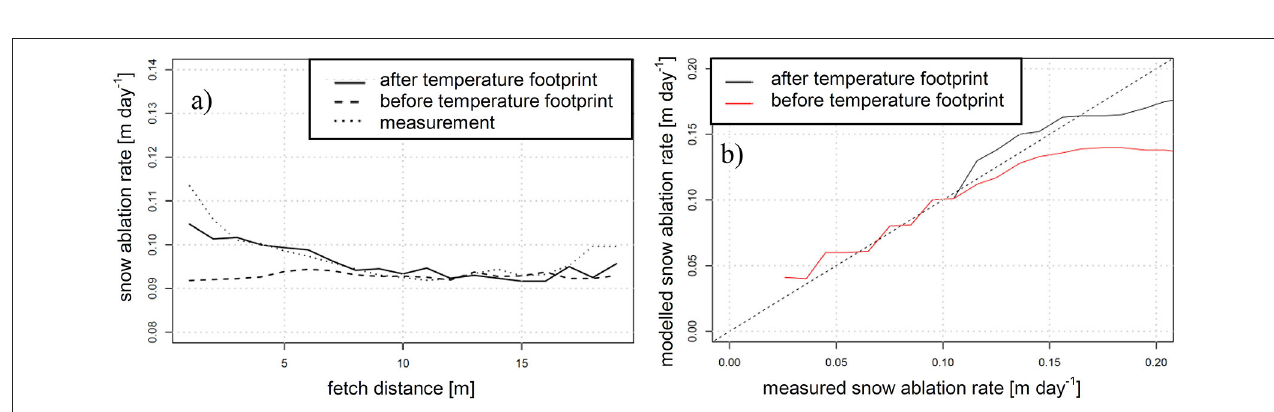
FIGURE 9 | Snow mask map for the Gletschboden area for the 22 May 2014. Model correctly provides snow (dark blue), model correctly provides bare ground (light blue). False alarms are shown in red, misses are shown in light green. White colors indicate no data. Snow mask maps are shown without the temperature footprint approach (A) and with the temperature footprint approach (B) .